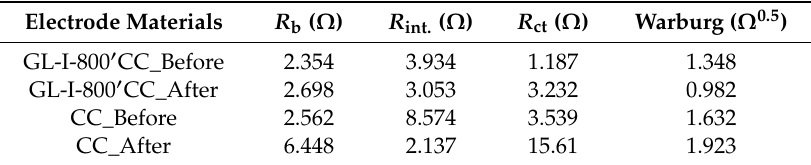
Table 5. EIS fitting results using a CPE model.